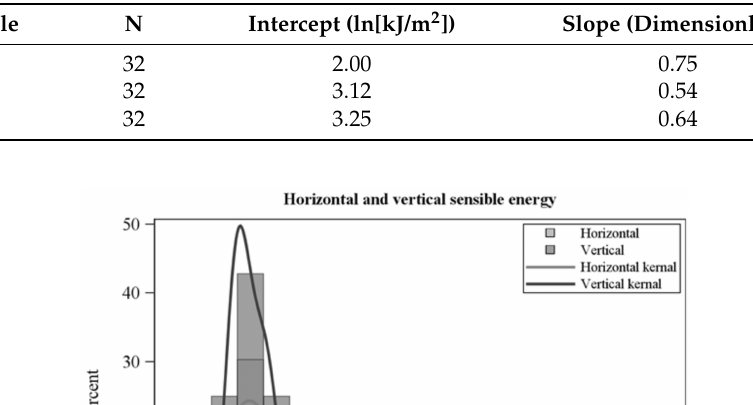
Table 3. Linear regression statistics for horizontal, vertical, and resultant sensible energies as a function of fire energy (see Figure 11). Dependent and independent variables were log-transformed.